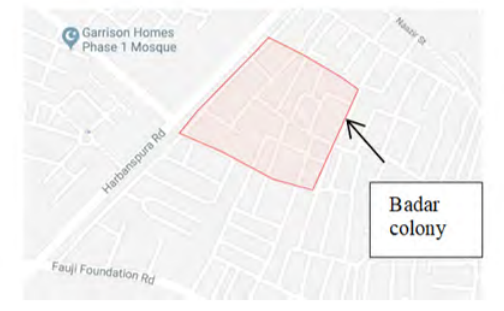
Figure 2. Google map for Badar Colony squatter